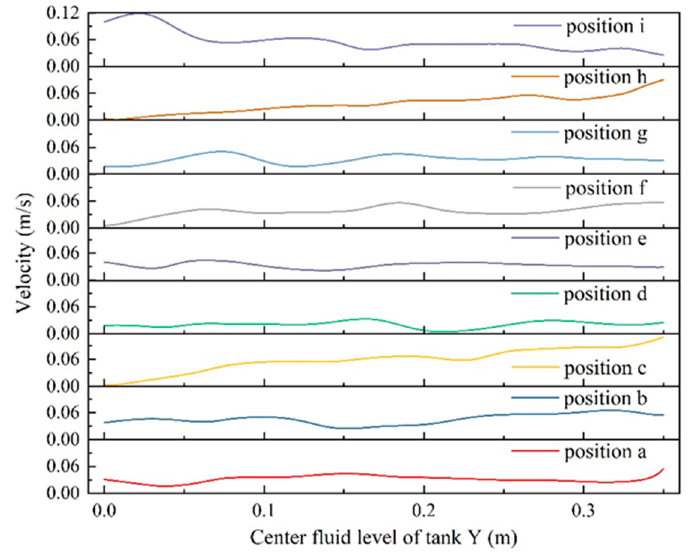
Figure 6. Flow velocity along the a–i